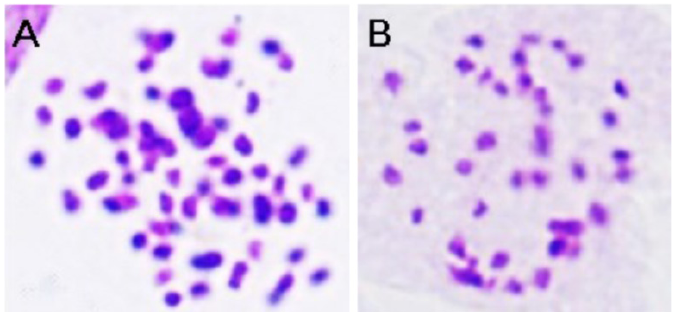
Figure 1. Number of chromosomes of diploid and triploid progenies—57 chromosomes in triploid ( A ) and 38 in diploid ( B